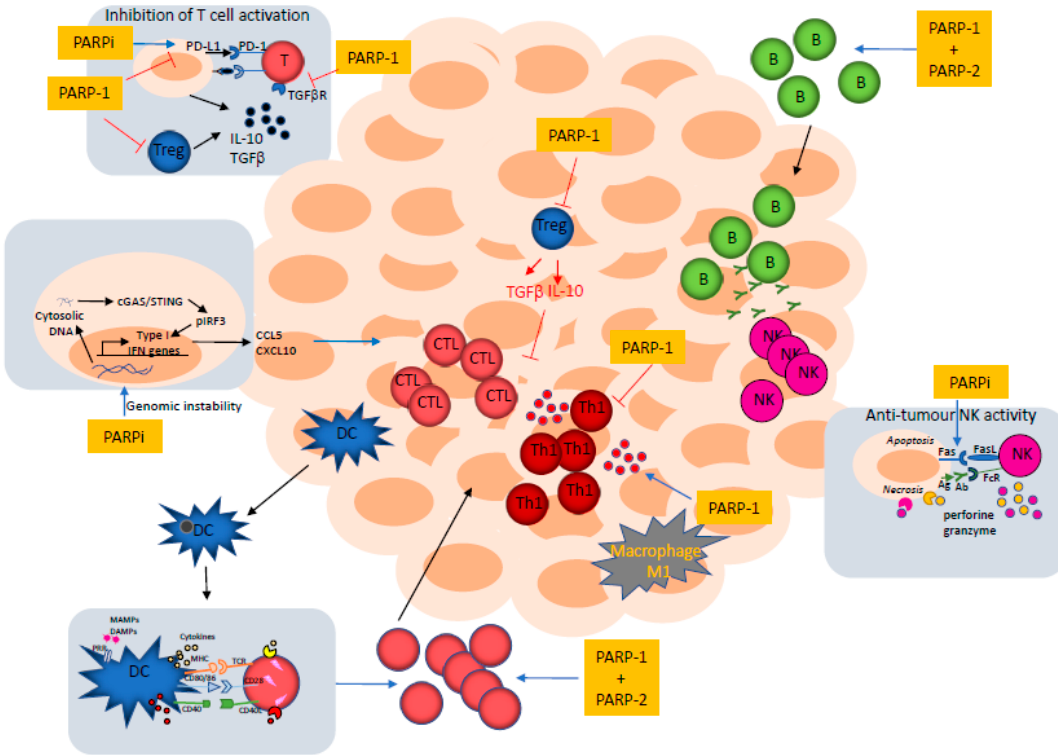
Figure 4. Schematic representation of the tumor microenvironment indicating the stages in which PARP-1 or its combination with PARP-2 or PARP inhibitors might play a role. In the boxes, we have included further details on the involvement of PARP-1 and/or PARP-2 or PARPi in certain contexts of the immune response. CTL, cytotoxic T cells; DC, dendritic cells; B, B cells; PARPi, PARP inhibitors. T cells, in particular, CD8 + cytotoxic T cells (CTL) and CD4 + Th1 cells, are major contributors to